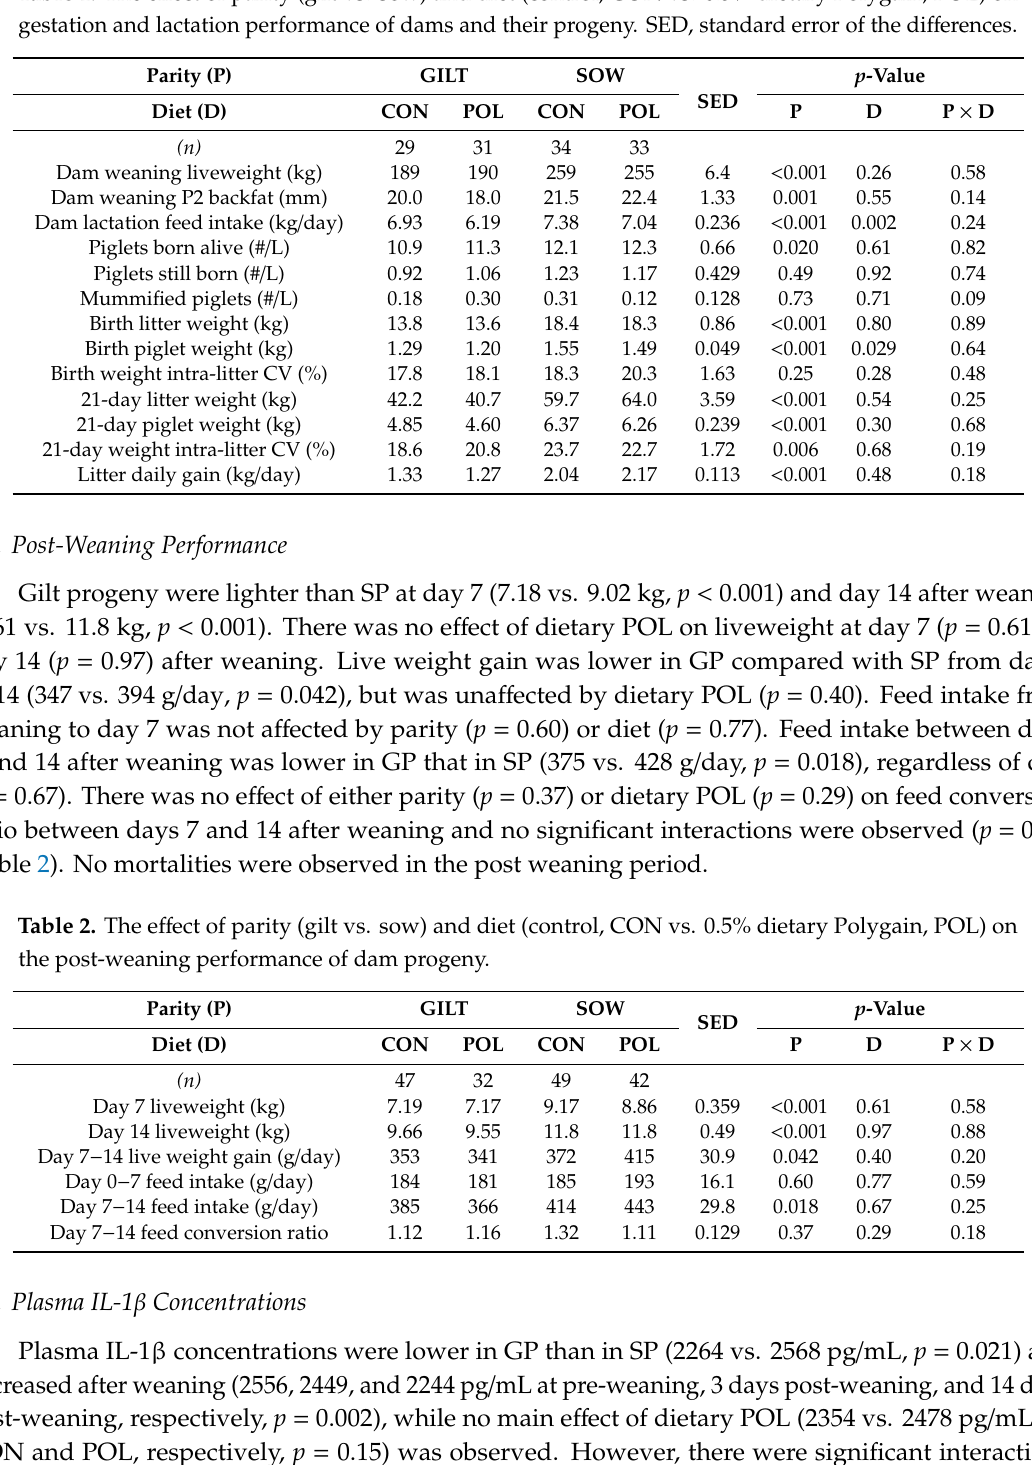
Table 1. The e ff ect of parity (gilt vs. sow) and diet (control, CON vs. 0.5% dietary Polygain, POL) on gestation and lactation performance of dams and their progeny. SED, standard error of the di ff erences. Parity (P) GILT SOW Diet (D) CON POL Dam weaning liveweight (kg)